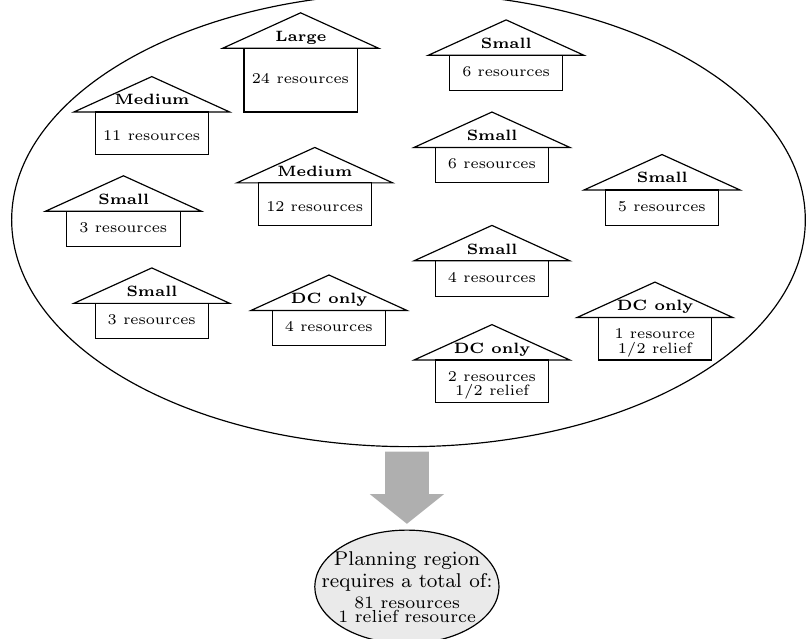
Figure 6: An illustrative example of how resources are aggregated for an entire planning